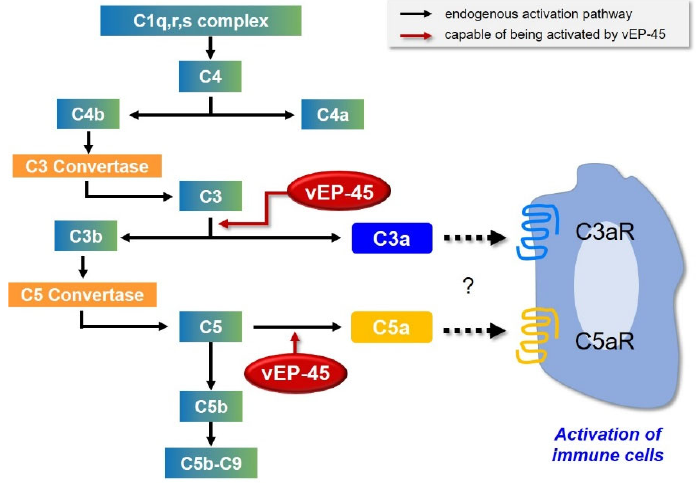
Figure 4. Effects of vEP ‐ 45 on the complement system during Vibrio infection.